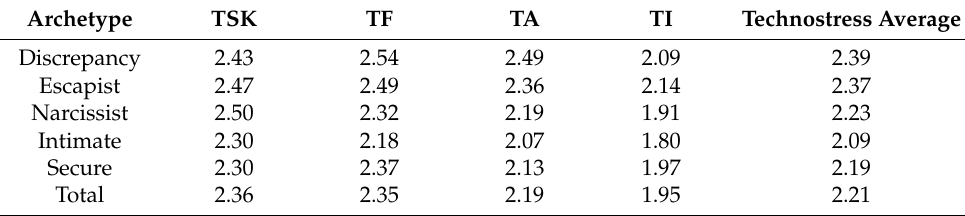
Table 11. Technostress by user type.